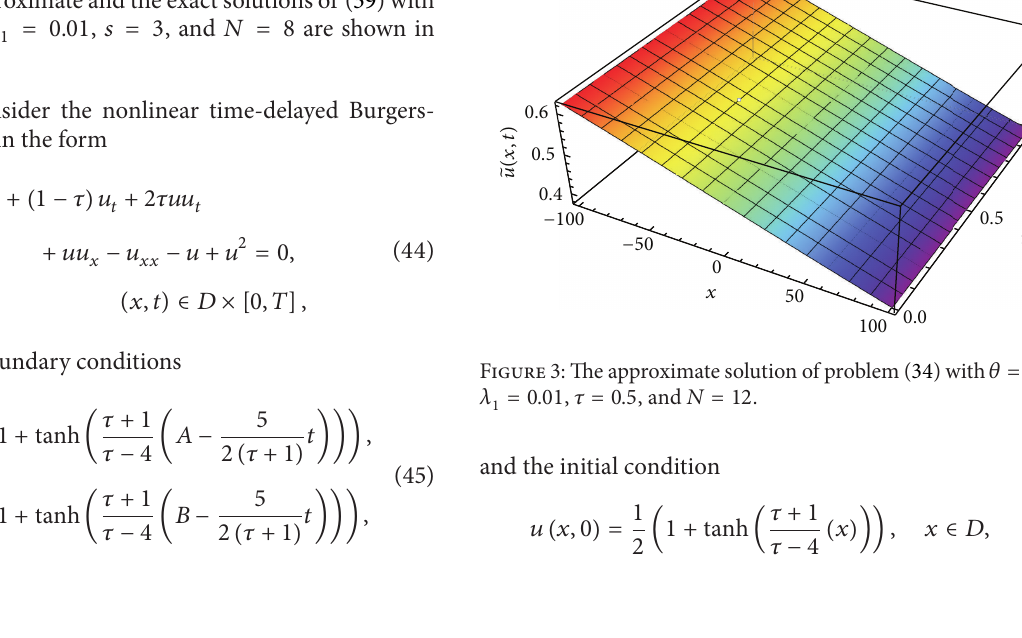
𝜆 = 0.01 , 𝑠 = 2 , and 𝑁 = 12 . Moreover, the absolute errors 1 between the approximate and the exact solutions of (39) with = 0.01 , 𝑠 = 3 , and 𝑁 = 8 are shown in 𝜃 = 𝜗 = 1/2 , 𝜆 1